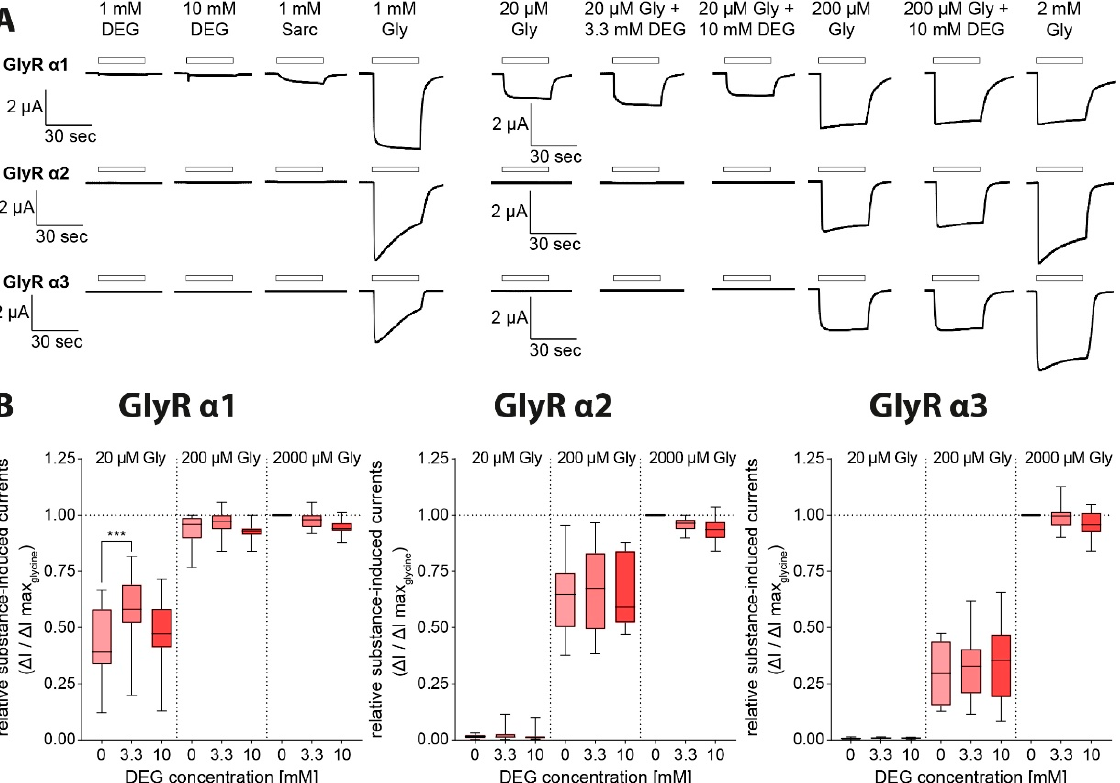
Figure 6. Current response of GlyR α 1 ‐ 3 after DEG application with and without glycine. ( A ) Original traces of electrophysiological measurements in Xenopus laevis oocytes expressing GlyR α 1 ‐ 3 individually after superfusion with DEG solution in increasing substance concentration (100 μ M, 333 μ M, 1 mM, 3.3 mM, 10 mM), sarcosine solution (1 mM) and glycine solution (1 mM) and after superfusion with different glycine solutions (20 μ M, 200 μ M, 2 mM) additionally containing amounts of DEG (0 mM, 3.3 mM, 10 mM). ( B ) Relative substance ‐ induced currents of GlyR α 1 ‐ 3 ‐ expressing oocytes in relation to the maximum observed current induced by 2 mM glycine (GlyR α 1 n = 24–37; GlyR α 2 n = 14–30; GlyR α 3 n = 12–29; data shown as boxplots, p < 0.001 (***), one ‐ way ANOVA with Bonferroni post ‐ hoc correction).